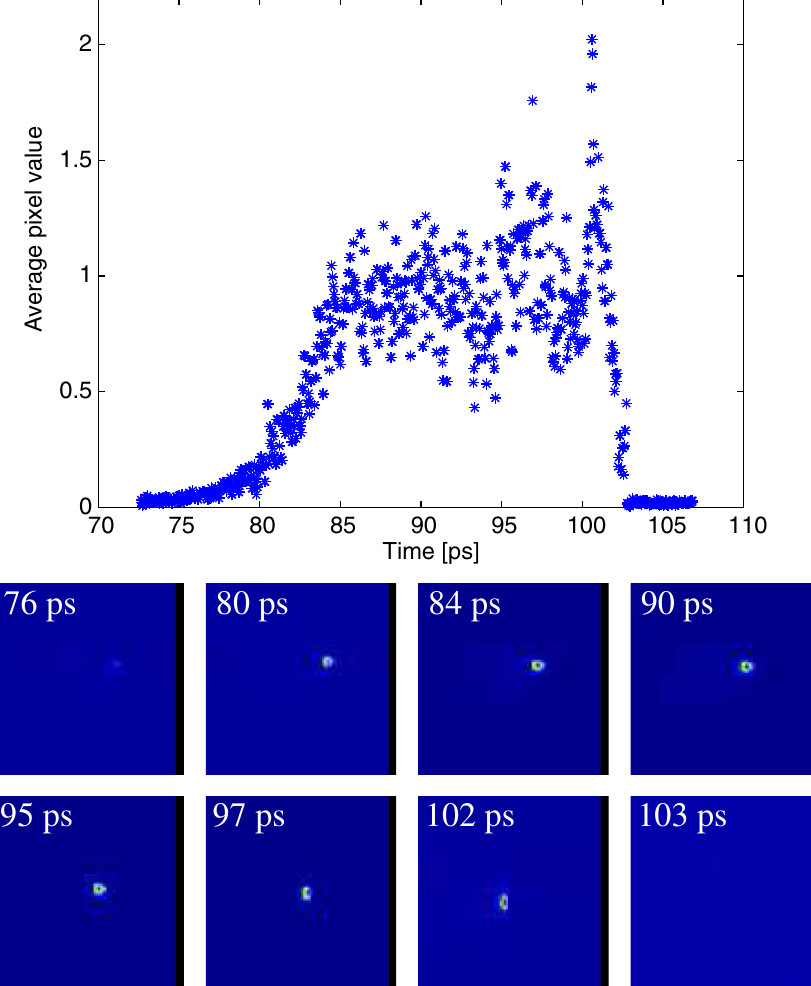
FIG. 3. (Color) A sequence of pictures (below) recorded on a camera on OS2 as the 200 fs laser pulse samples different longitudinal slices of the electron bunch. The size of the area shown on the pictures is 5 mm by 5 mm. The upper plot shows the average pixel value in a small region around the spot. It shows a clear enhancement as the laser passes the electrons from the tail of the electron bunch at the left towards the head of the bunch at the